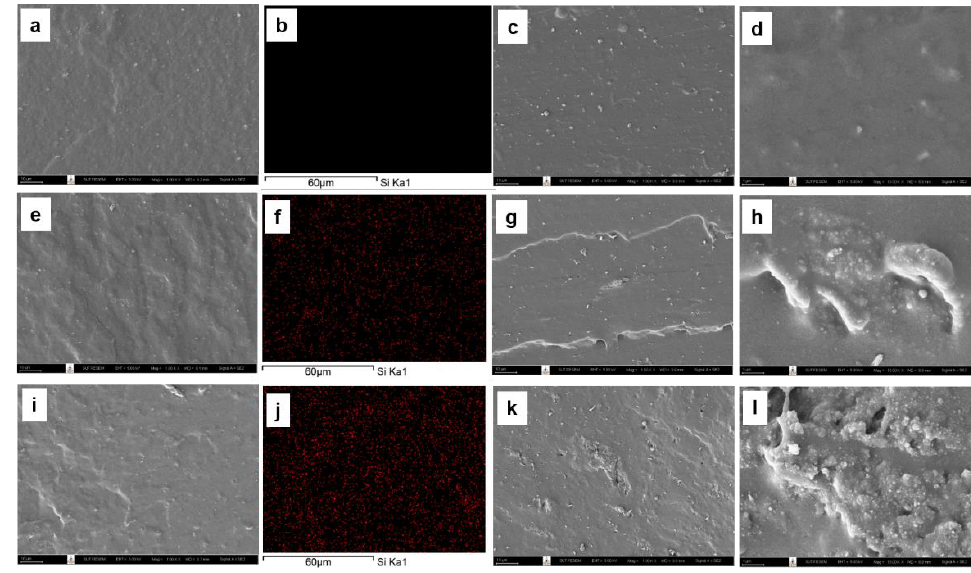
Figure 12. SEM images of freeze fracturing, corresponding EDS (the red spots indicate silica particles), and tensile fracture surface at ×1000 and ×10,000 magnifications of ( a – d ) P10-DPNR; ( e – h ) P10-DPNR-10Si; ( i – l ) P10-DPNR-20Si.